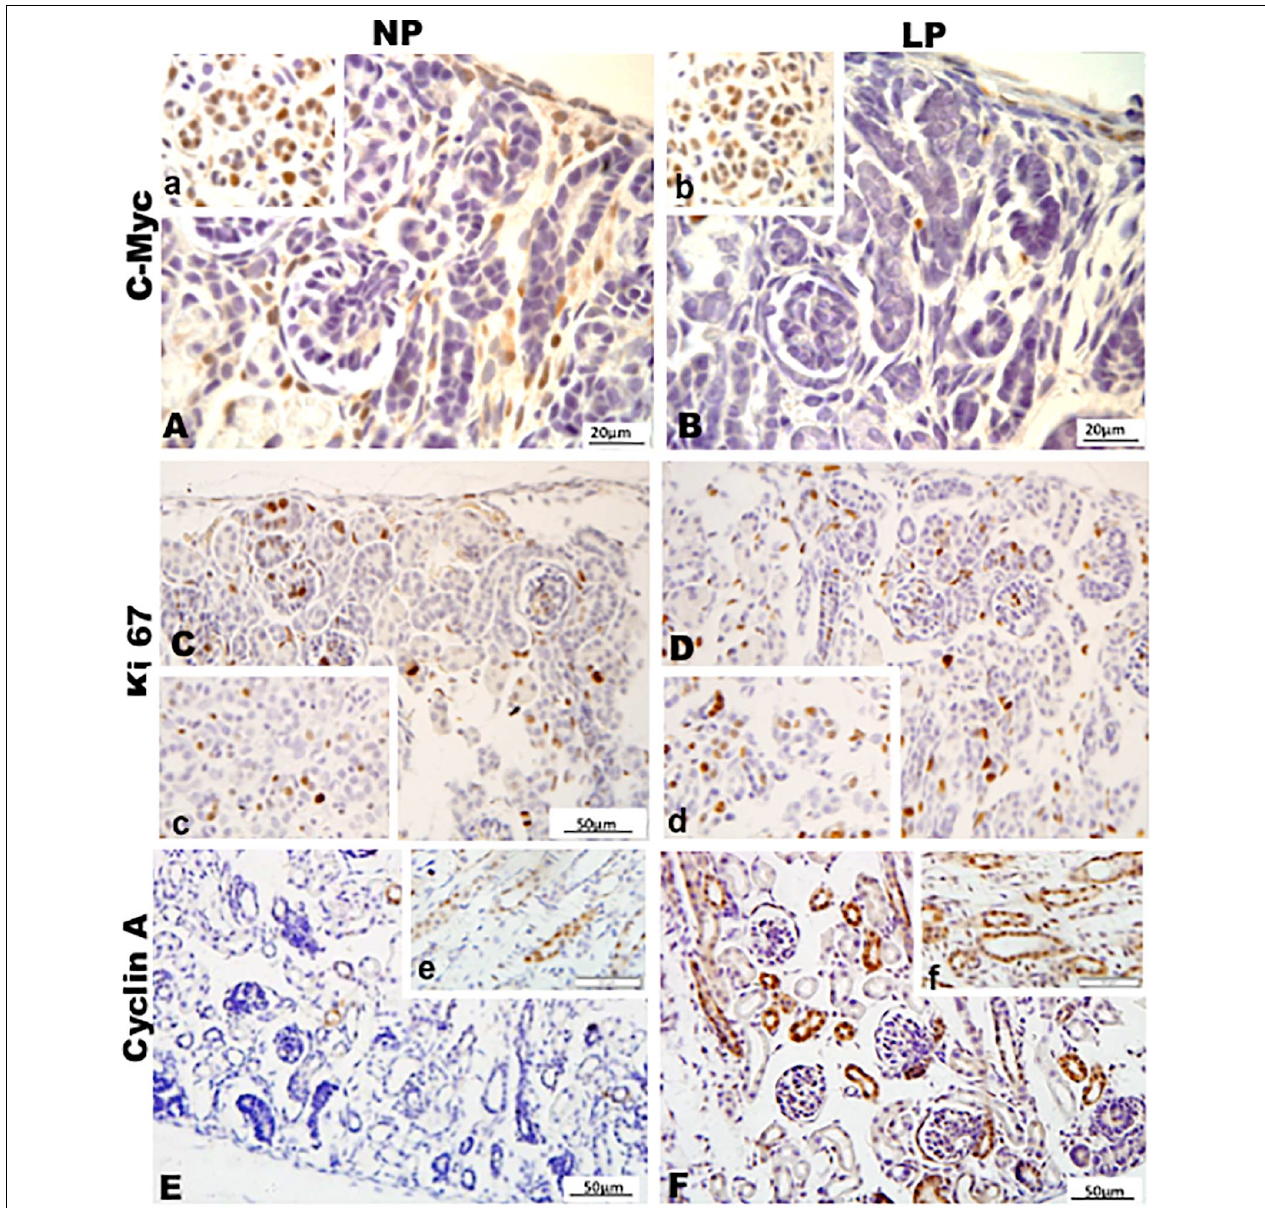
FIGURE 9 | Immunoperoxidase in kidneys of 7DL rats for (A,B) c-Myc, (C,D) Ki67, and (E,F) cyclin A for the NP (A,C,E) and LP (B,D,F) groups. The inserts represent the medullar